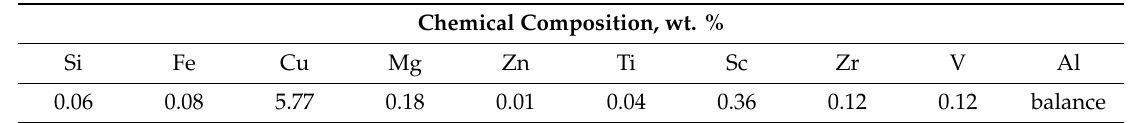
Table 1. Composition of AA2519 [36].